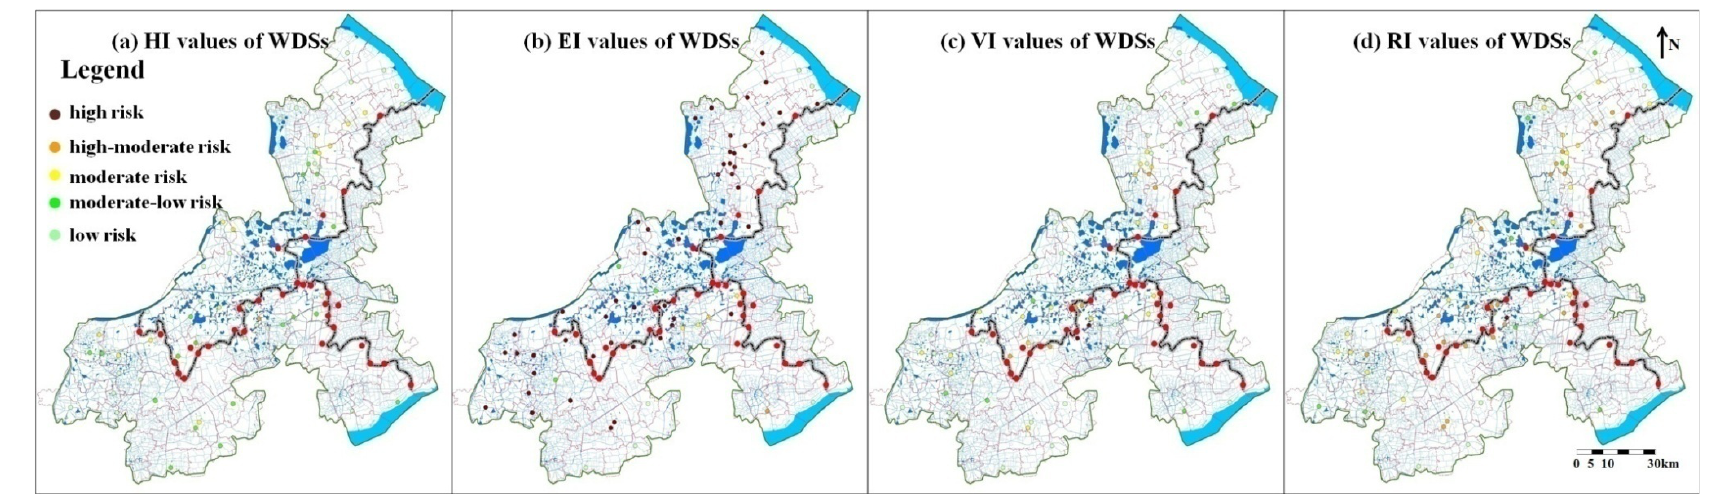
Figure 6. Spatial distribution of HI, EI, VI and RI values of the CSSs.